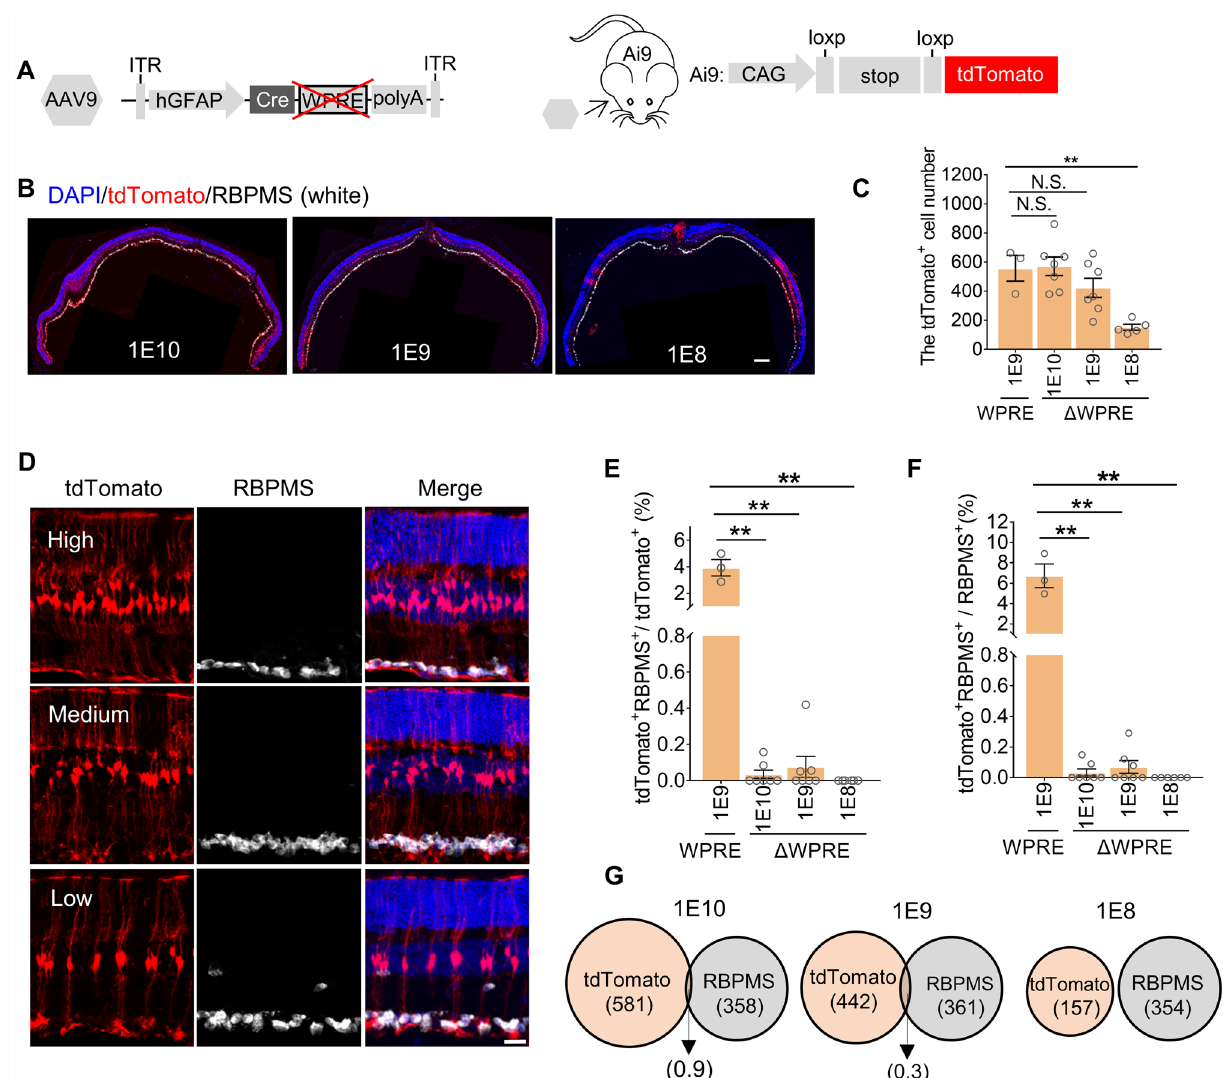
Figure 2. Reduced leakage in the RGCs with the ΔWPRE system. ( A ) Schematic diagram of the hGFAP- Cre- Δ WPRE vector and the tdTomato reporter construct in the Ai9 mouse line. ( B ) Representative images of tdTomato co-localization with Rbpms in mouse retinas following subretinal injection with different doses of AAVs (from left to right:1 × 10 10 , 1 × 10 9 , 1 × 10 8 vg/eye). Scale bar, 200 μm. ( C ) The average number of tdTomato + cells in each eye section transduced by different doses of AAVs. ( D ) Representative images of tdTomato co-labeling with the RGC marker in different densities of labeled MG in retina sections. Scale Bar, 50 μm. ( E,F ) The ratio of tdTomato-labeled MG among total labeled cells (E) and RGCs (F). 3 eye sections near the injection site for each retina were chosen to count cells, and their average values were shown and analyzed. ( G ) Venn diagram of the average number of tdTomato-labeled cells and RGCs. n = 3 ~ 7 retinas per group for panels C, E, F. All values are presented as means ±